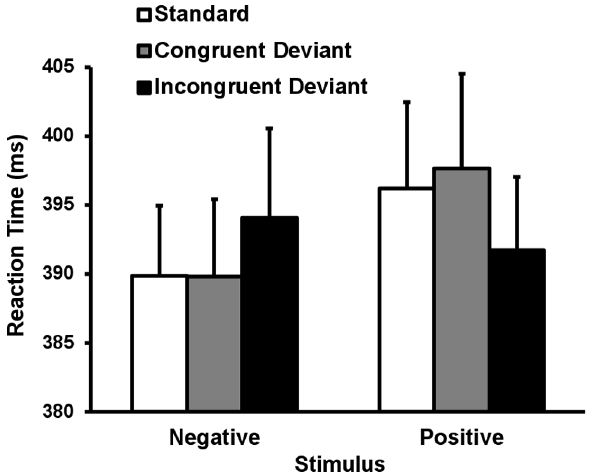
Figure 6. Mean reaction times and SEMs for each condition.